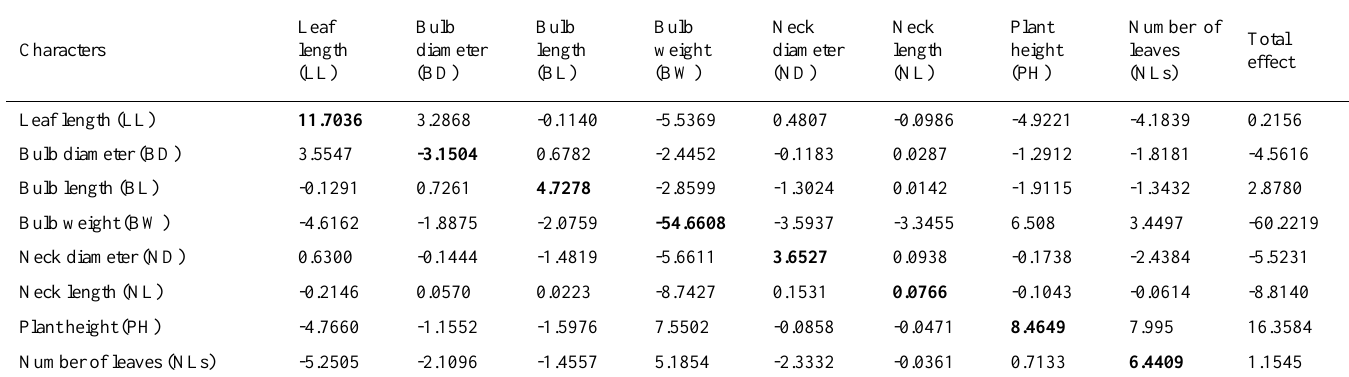
Table 5 . Path coefficient analysis showing direct (bold diagonal) and indirect effects of yield components on bulb yield of onion at genotypic level